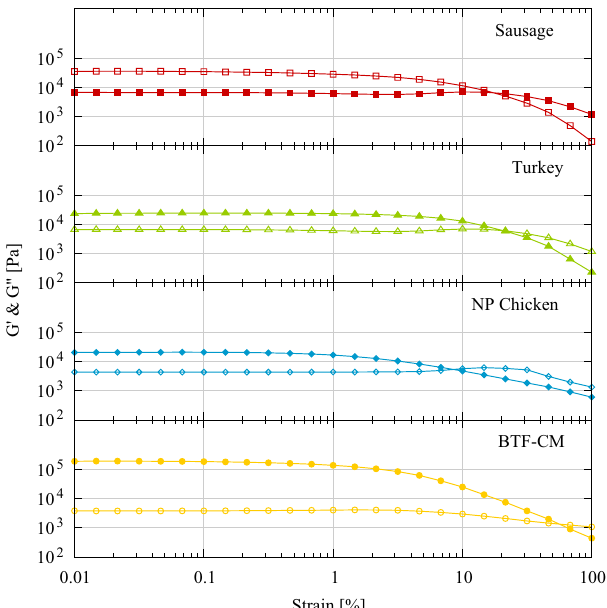
Figure 4. Mean values (N ≥ 4) of storage modulus (G’) and the loss modulus (G”) from sweep amplitude test for meat samples (γ = 0.01–100%, frequency = 10 Hz, gap 3